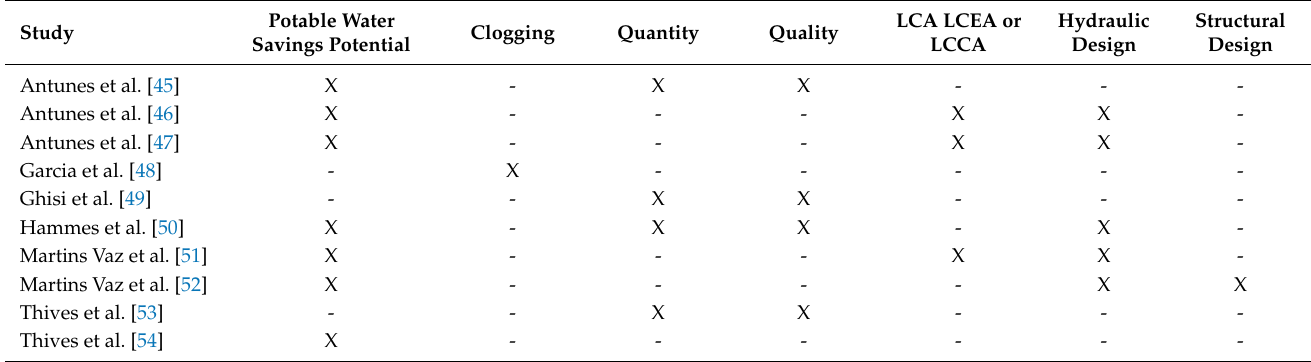
Table 2. Subjects addressed in each